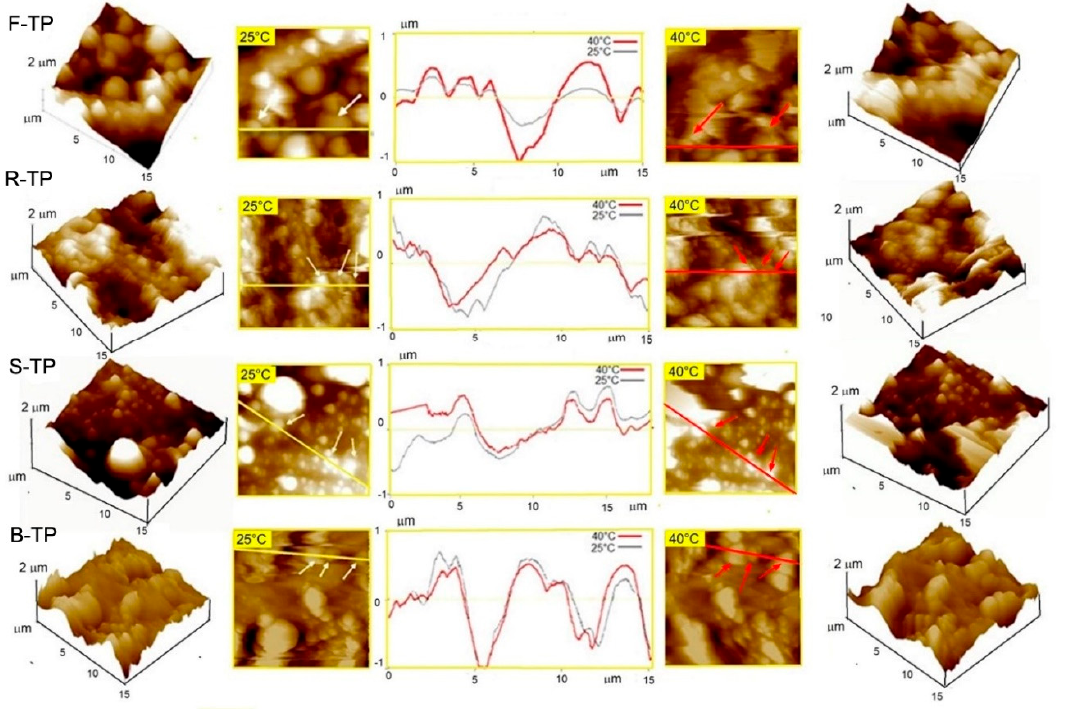
Figure 11. Two typical section profiles (middle) obtained at 25 °C and 40 °C with the image processing system for the thermochromic print on: (F-TP) filter paper; (R-TP) recycled paper; (S-TP) synthetic paper and (B-TP) bulky paper and corresponding 3D height images at 25 °C (left) and 40 °C (right). The analysis of section profiles enables the diameter and height to be determined. The asymmetry of the profiles is due to friction effects of the tip on microcapsules. Vertical scale is height in micrometers for all 3D images and in nanometers in all section profiles.